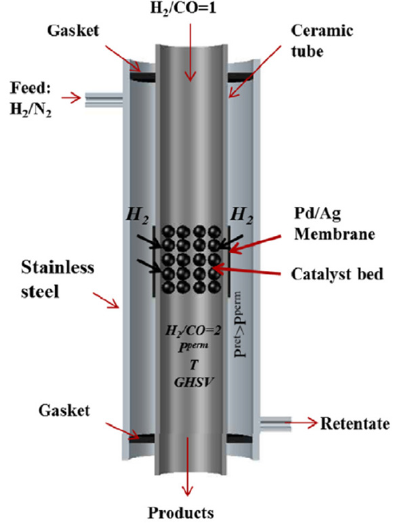
Figure 10. Schematic drawing of the Fischer ‐ Tropsch Packed ‐ Bed Membrane Reactor (FTS PB ‐ MR) used for lab ‐ scale demonstration with H 2 distribution into the bed via Pd ‐ Ag membrane [24].